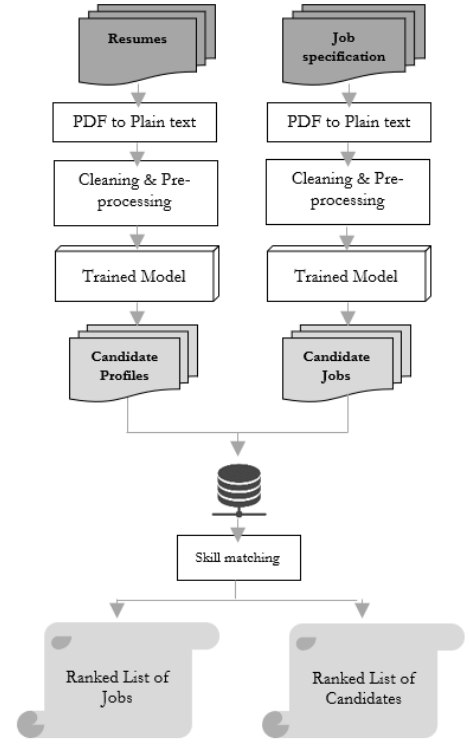
Figure 6. Matching jobs and candidate profiles using the trained model.